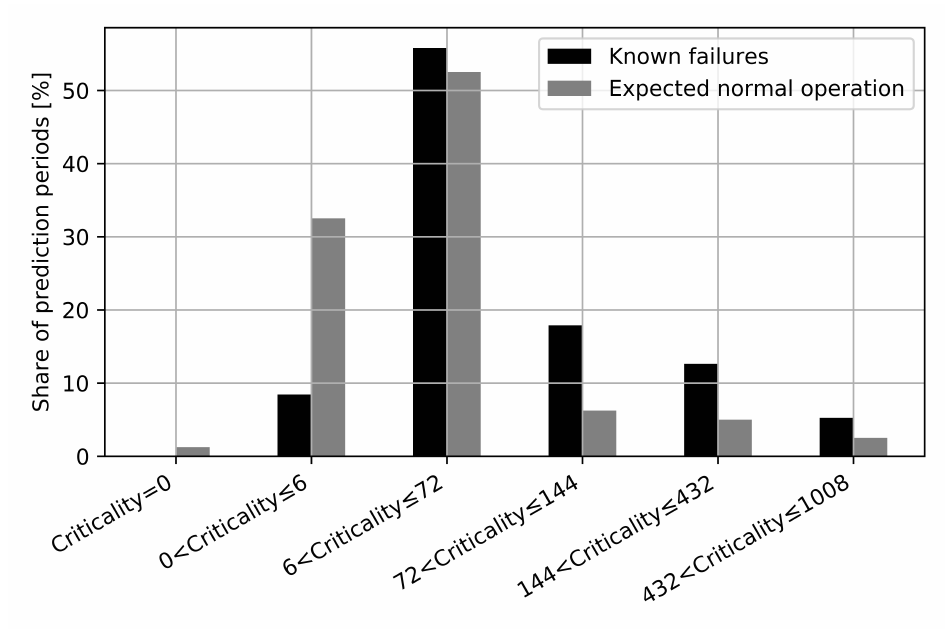
Figure 3. Comparison of prediction